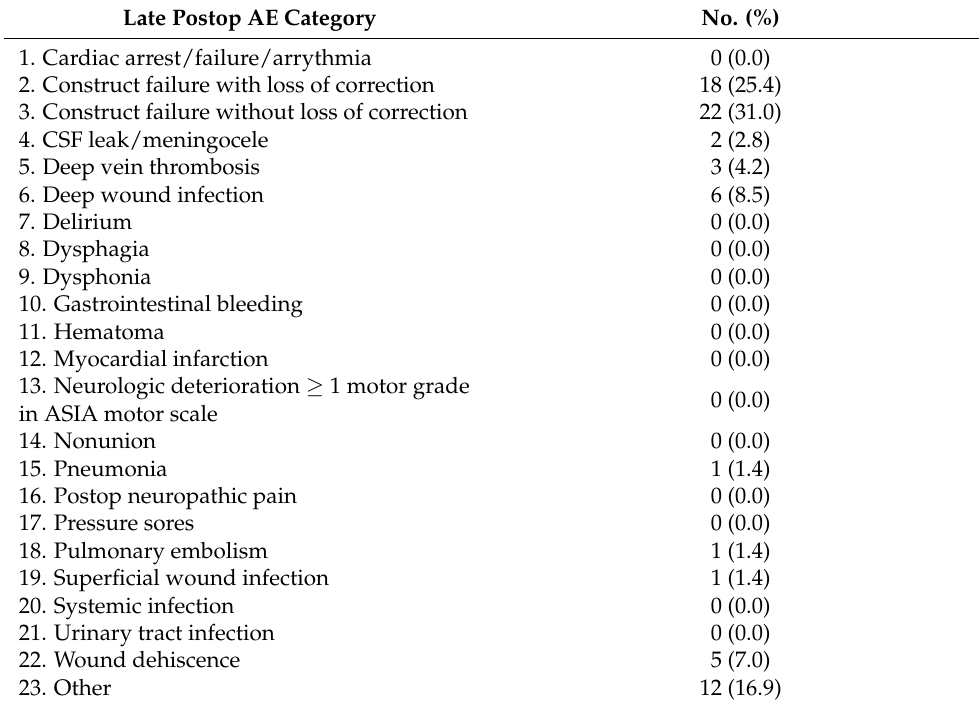
Table 6. Late post-operative